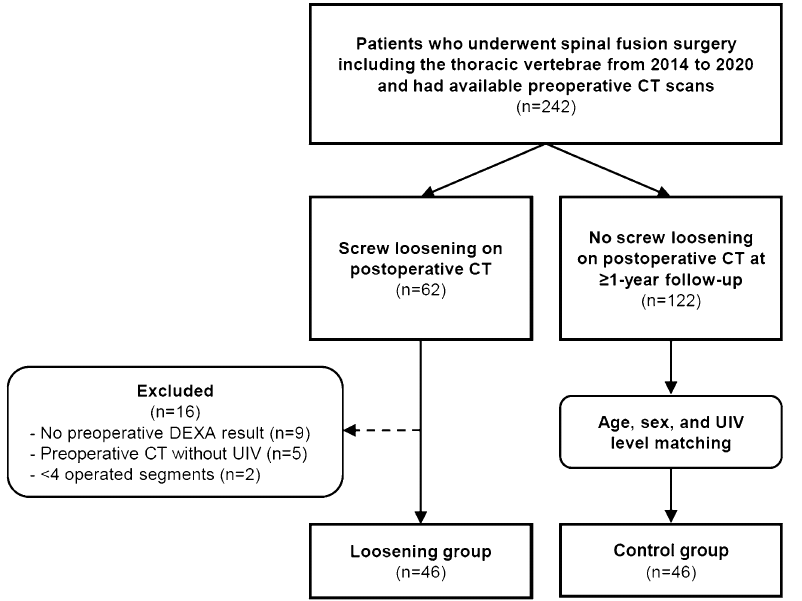
Figure 1. Flow diagram of patient selection. DEXA, dual-energy X-ray absorptiometry; UIV, upper instrumented